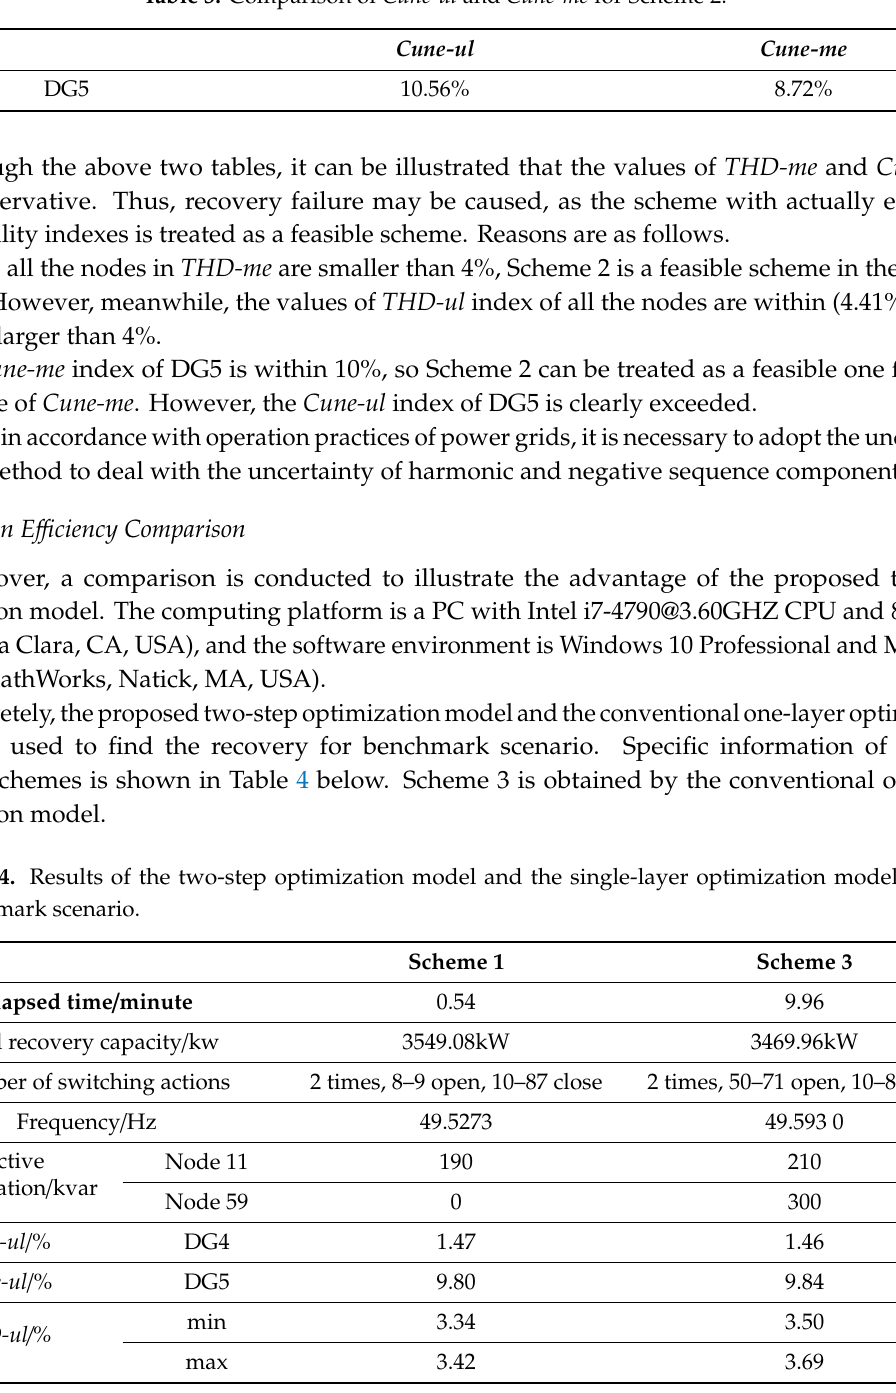
Table 3. Comparison of Cune-ul and Cune-me for Scheme 2.